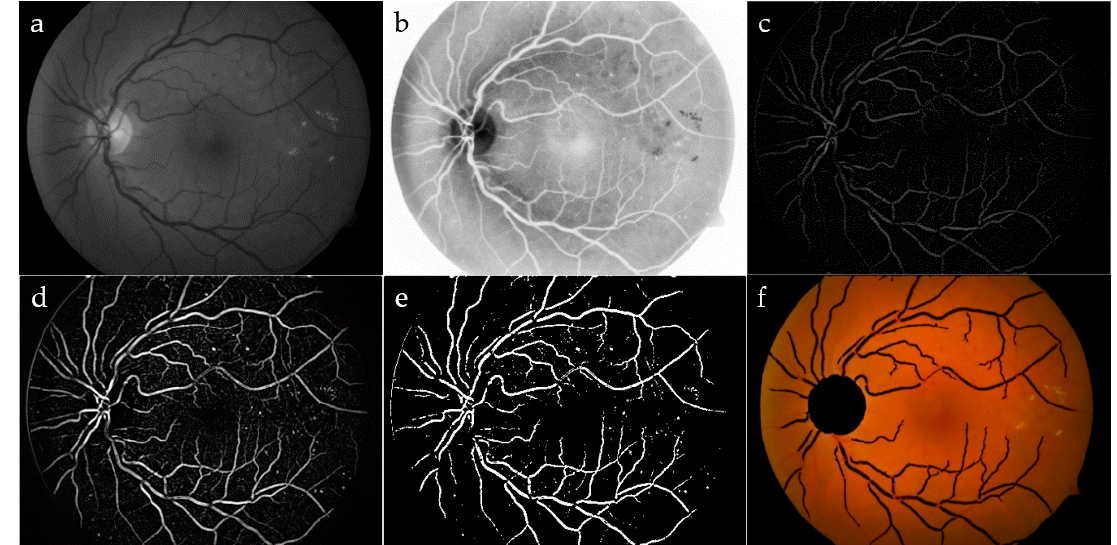
Figure 3. Vessel segmentation: green channel ( a ) and its CLAHE enhancement ( b ); area opening, followed by Gaussian filtering ( c ); top-hat transform ( d ); adjusted intensity ( e ); OD and blood vessels have been removed by the original image ( f ).